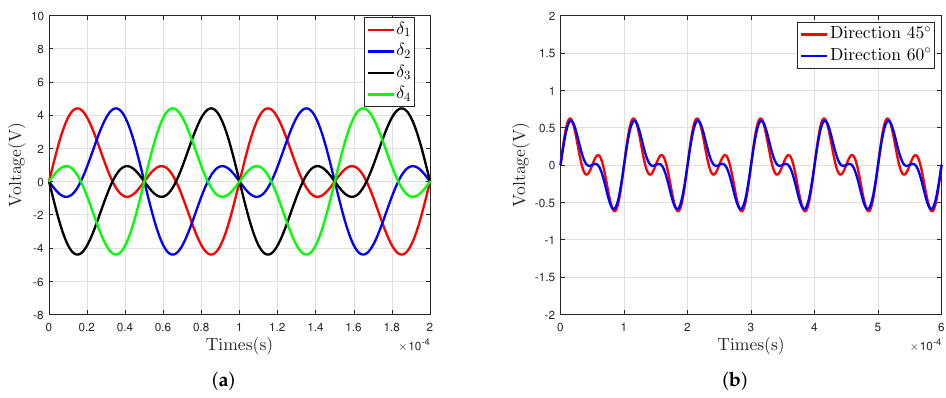
Figure 6. Simulation results of the signal process circuit: ( a ) driving circuit and ( b ) sensing